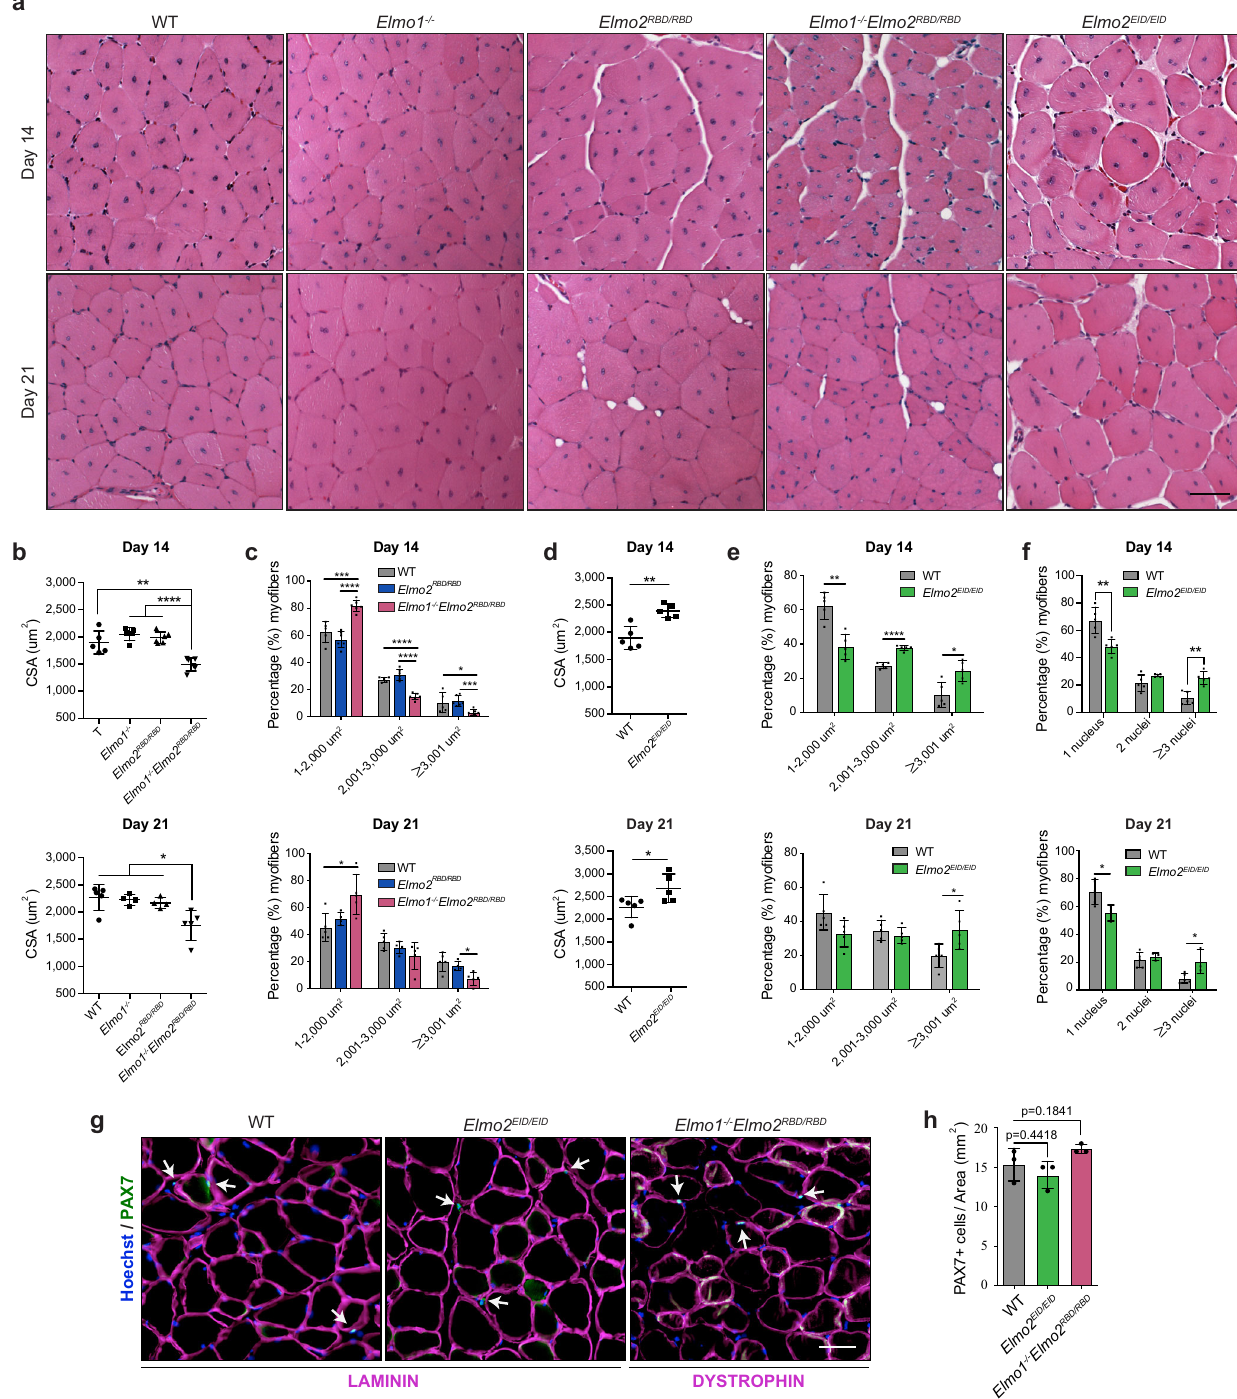
Fig. 3 | Manipulating ELMO2 conformational regulation impacts on myoblast fusionduringmuscleregeneration.a Representativecross-sectionsofTAmuscle 14 and 21days following CTX-induced injury. b – f Quanti fi cation of ( a ) showing b , d themeanCSApermice, c , e thepercentage(%)ofmyo fi bersatdifferentranges ofmyo fi bersizeand f thenumberofnucleipermyo fi bersatday14and21following injury for the indicated mice. Data are presented as the mean values+/ − SD ( n =5 mice). g , h ThenumberofPAX7-positivecellsisnotaffectedinboth Elmo2 EID/EID and